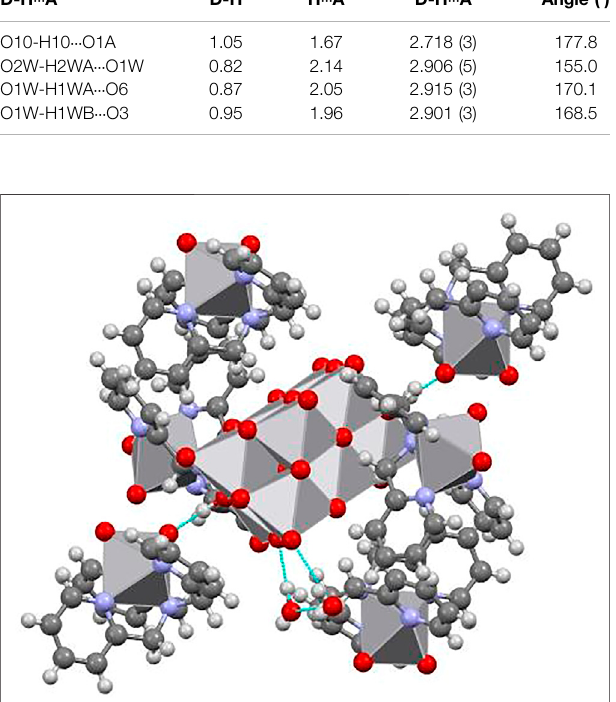
FIGURE 5 | Supramolecular structure showing how a single diprotanated decavanadate is surrounded by six moieties of [VO 2 (tpma)] + .